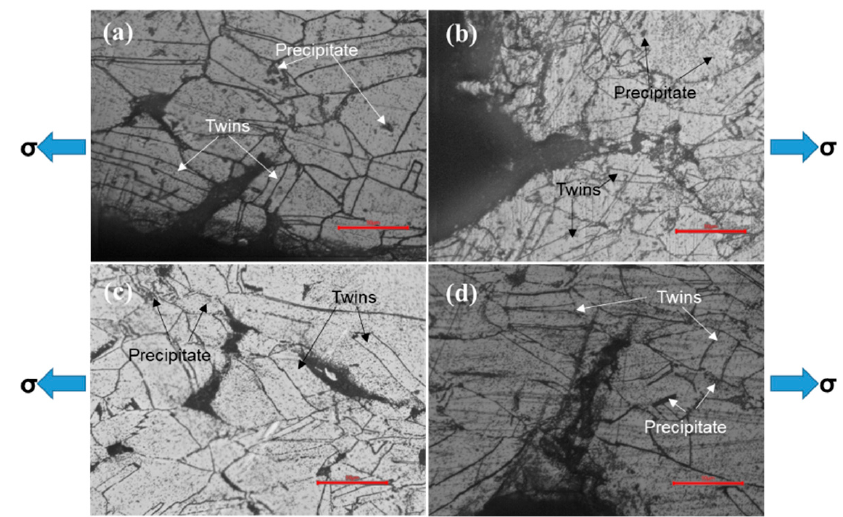
Figure 18. Microstructural observations of the near section of fracture at 253 MA without ( a ) annealing time and annealing times of ( b ) 900; ( c ) 1800; ( d ) 3600 s after creep rupture test with a 500X magnification.